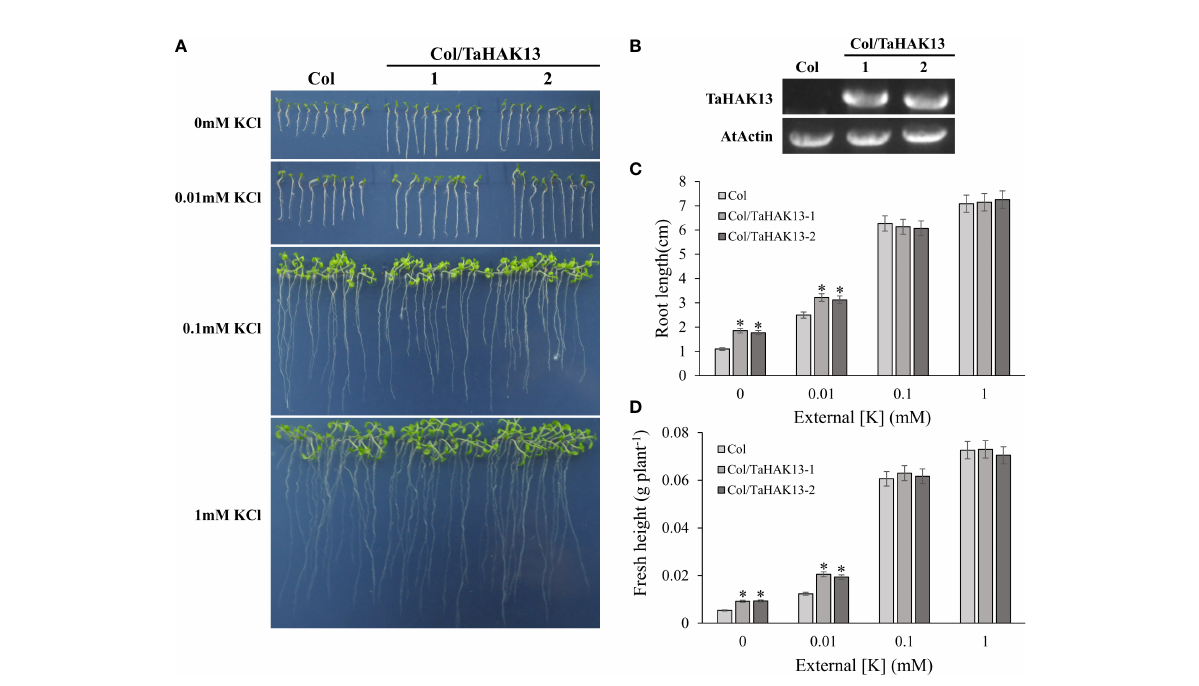
FIGURE 7 Functional veri fi cation of TaHAK13 in wild-type Arabidopsis thaliana. (A) Wild-type (Col) and transgenic lines (Col/ TaHAK13 ) were grown on MS media with different K + concentrations for 10 d. (B) The expression of TaHAK13 in Col and transgenic Arabidopsis thaliana was quanti fi ed via RT- PCR. (C) The root length of the plant in each bar represents the average root length of 20 seedlings from three independent experiments. (D) The fresh weight of plants in each bar represents the average fresh weight of 20 seedlings from three independent experiments. The Student t- test (* p <0.05) was used to analyze the statistical signi fi cance.